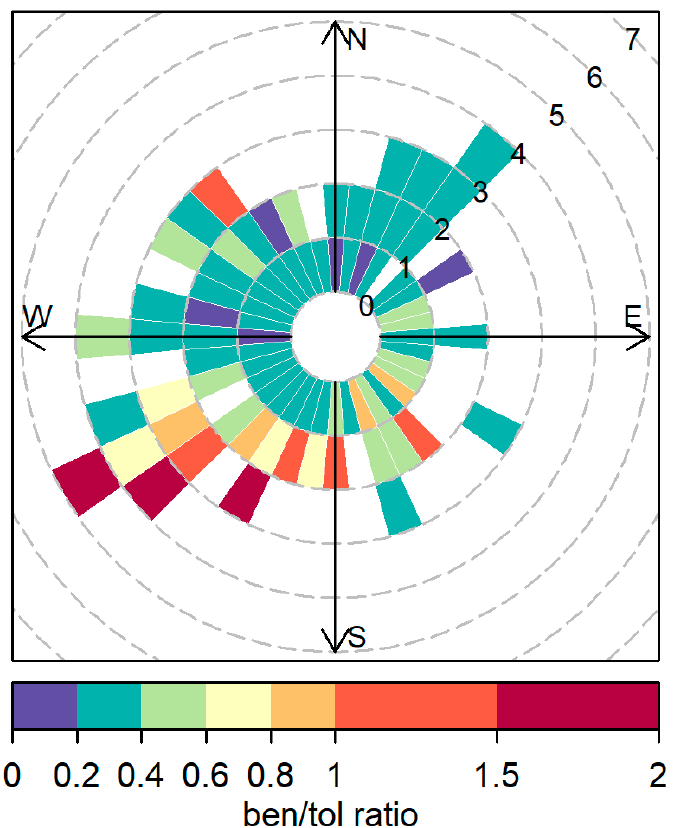
Figure 14. Polar plot showing the benzene to toluene ratios during nighttime and stable atmos- phere.